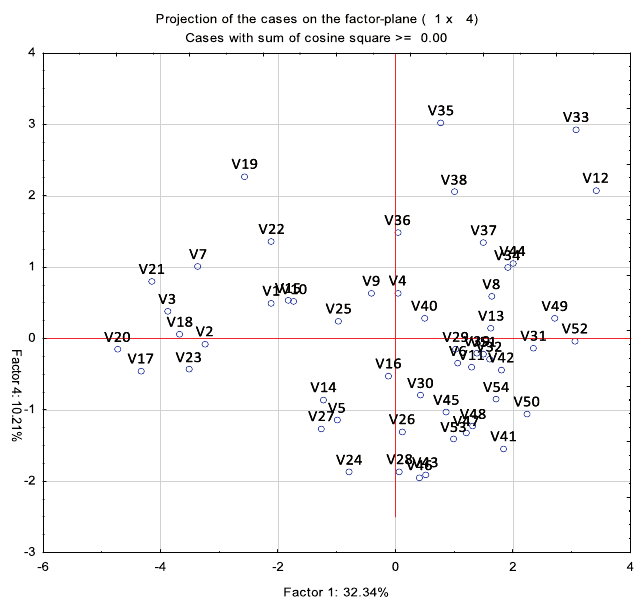
Fig. 2: Biplot graph of 54 genotypes under high temperature stress on the basis of various traits.